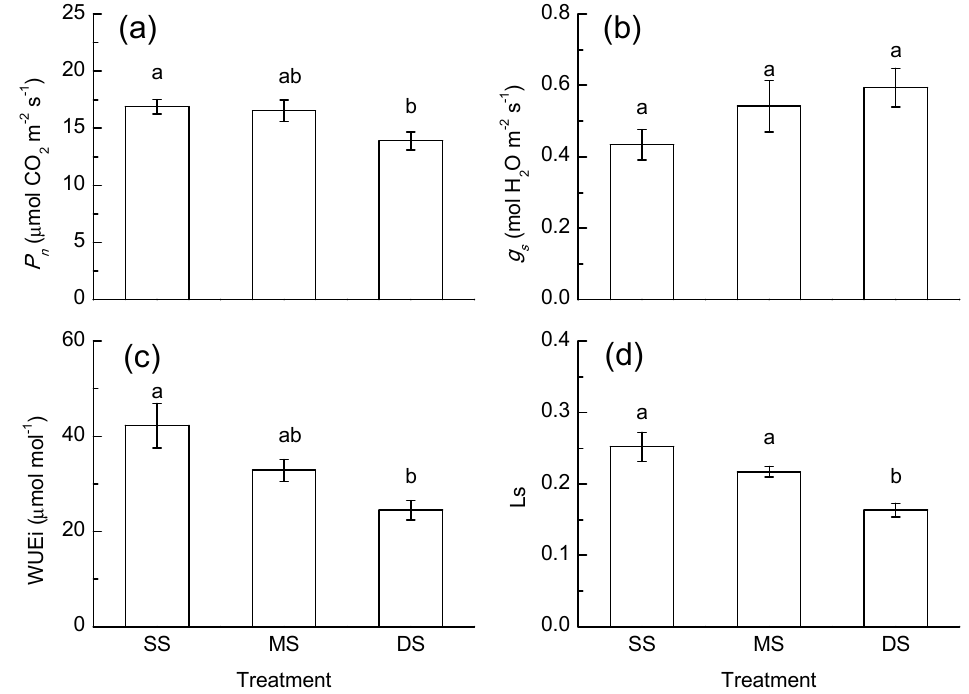
Figure 2. Net photosynthetic rate ( P n ) ( a ), stomata conductance ( g s ) ( b ), intrinsic water use efficiency (WUEi) ( c ) and limiting value of stomata (Ls) ( d ) of S. matsudana under shallow submergence (SS), moderate submergence (MS) and deep submergence (DS) treatment in the hydro-fluctuation zone of the TGDR. Different letters on each bar represent significant difference among treatments at the 0.05 level. Values are means ± standard error ( n = 9).